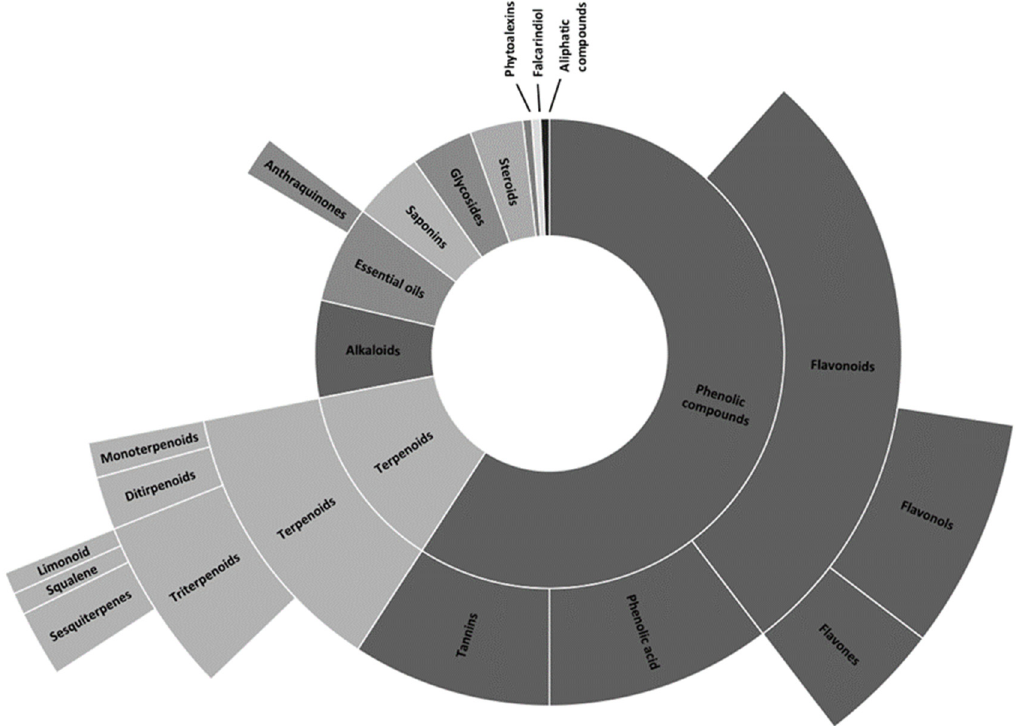
Figure 3. Diversity of bioactive compounds (secondary metabolites) with antimicrobial activity produced by halophyte plants.